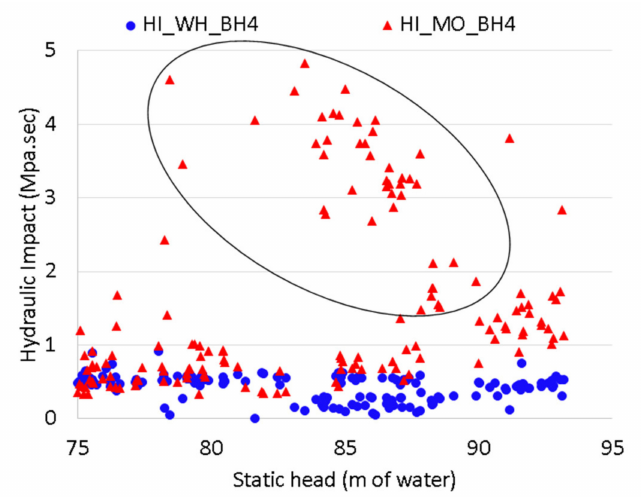
Figure 14. Effect of static head before transient on hydraulic